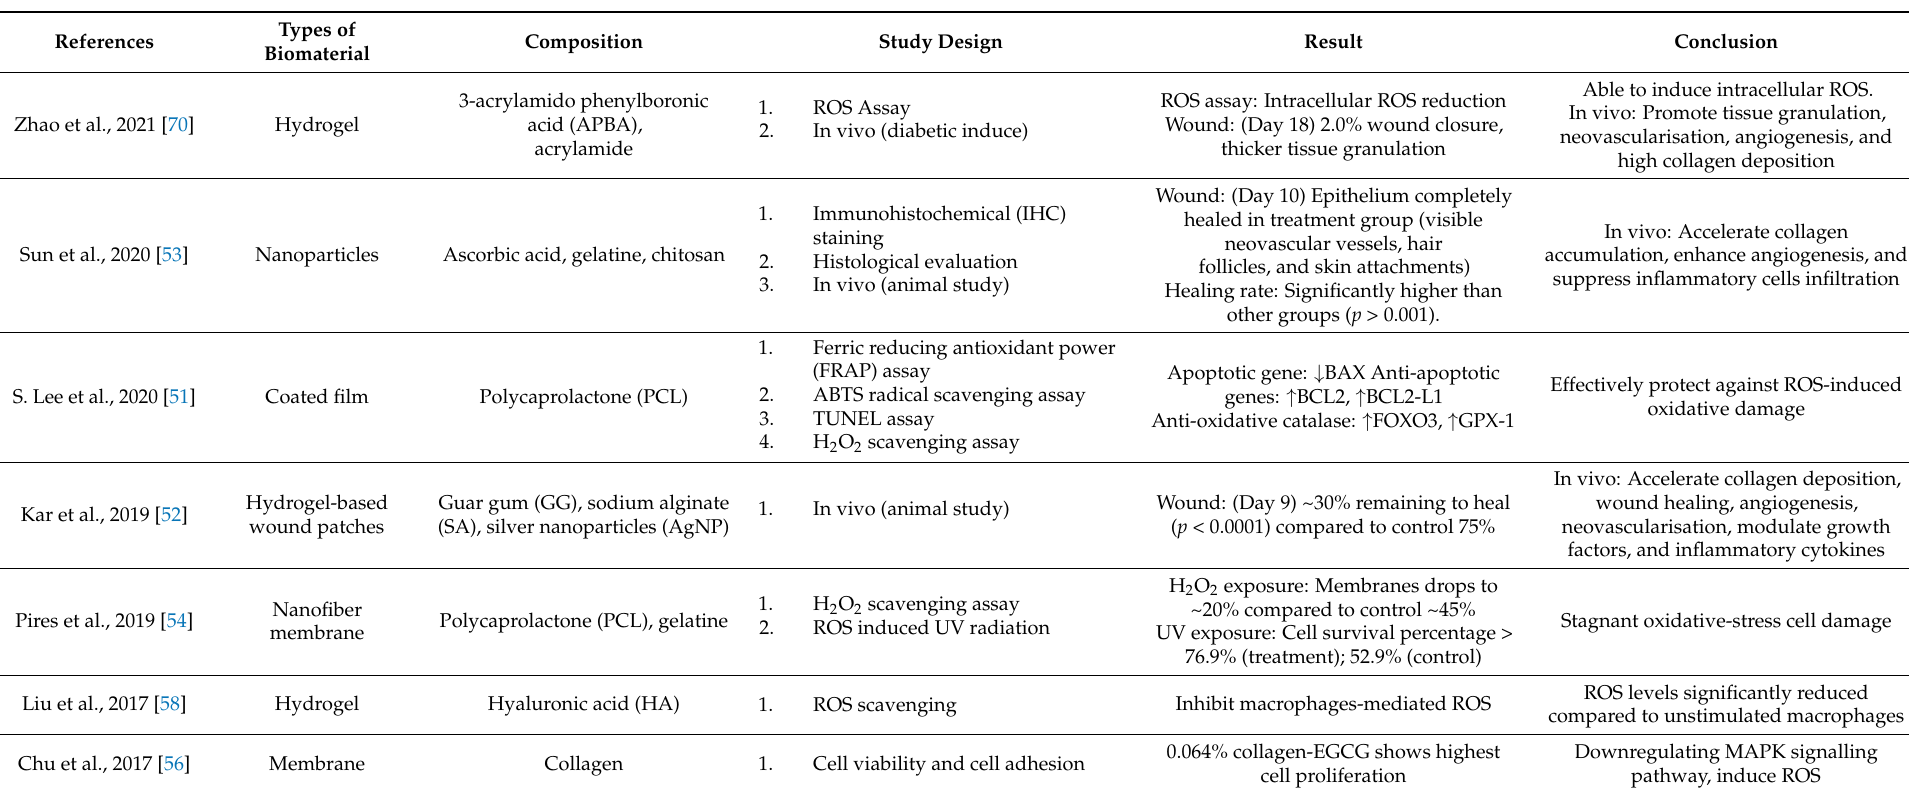
Table 2. Current study of EGCG incorporated